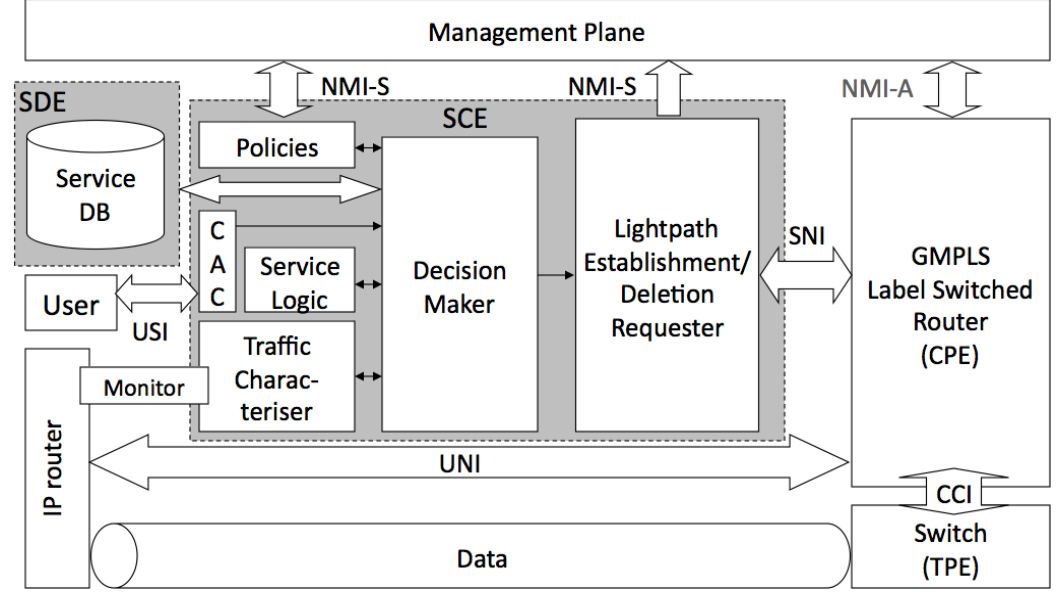
Figure 4. Proposal for QoS-oriented service plane